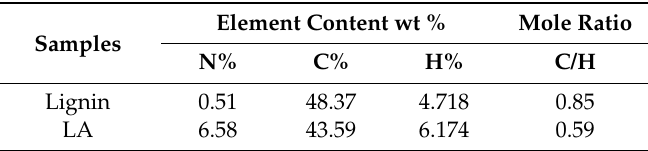
Figure 3. ( a ) FT-IR spectrum of lignin and LA; and ( b ) TGA curves of all samples. The insert of ( a ) is the enlargement of the gray rectangular region. Table 2. Element analysis results of lignin and LA.